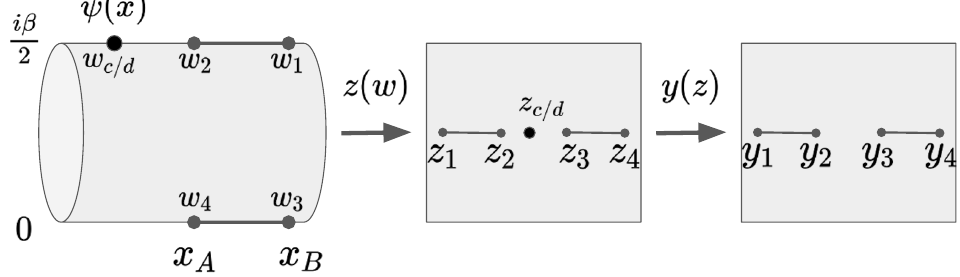
Figure 1 . Our setup in the computation of re(cid:13)ected entropy. We consider two symmetric intervals [ x A ; x B ] in both copies of the CFT, perturbed by the heavy operator insertion in the left copy at time t in the past. Using two conformal maps, z ( w ) and y ( w ), we map this setup to the known vacuum